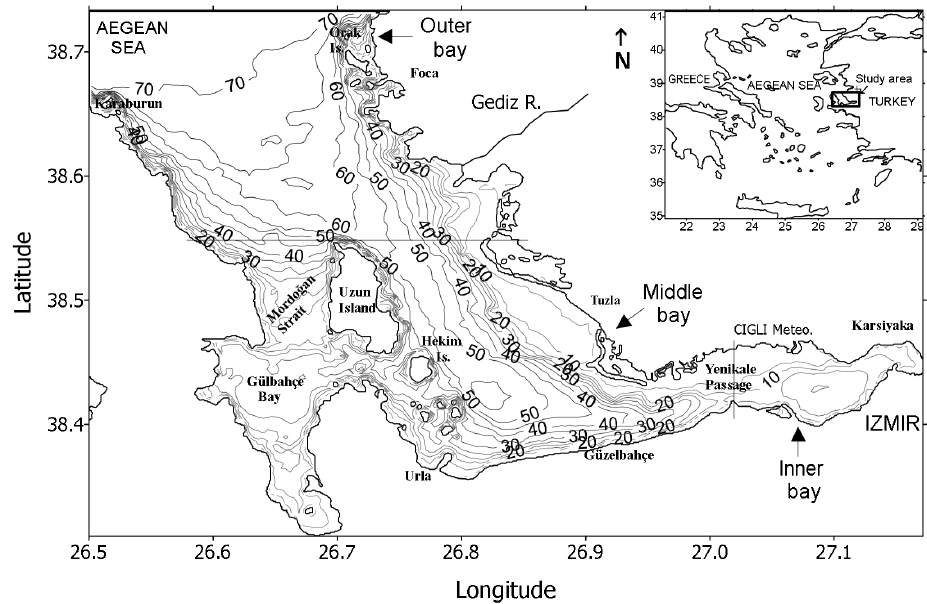
Figure 1. Location of ˙Izmir Bay and study area